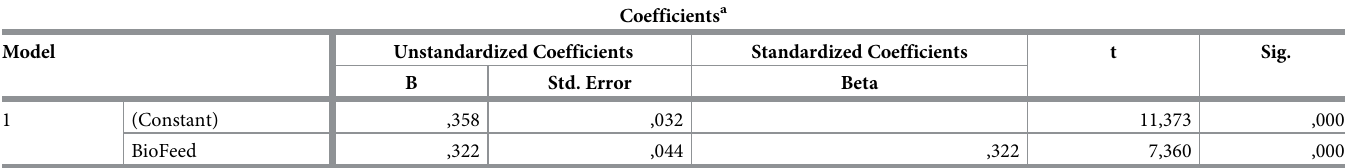
Table 2. Linear regression between biofeedback and performance.